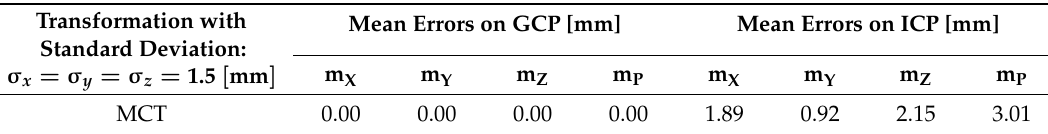
Table 14. Mean errors of transformations (standard deviation) for laboratory data distorted by random errors according to normal Gaussian